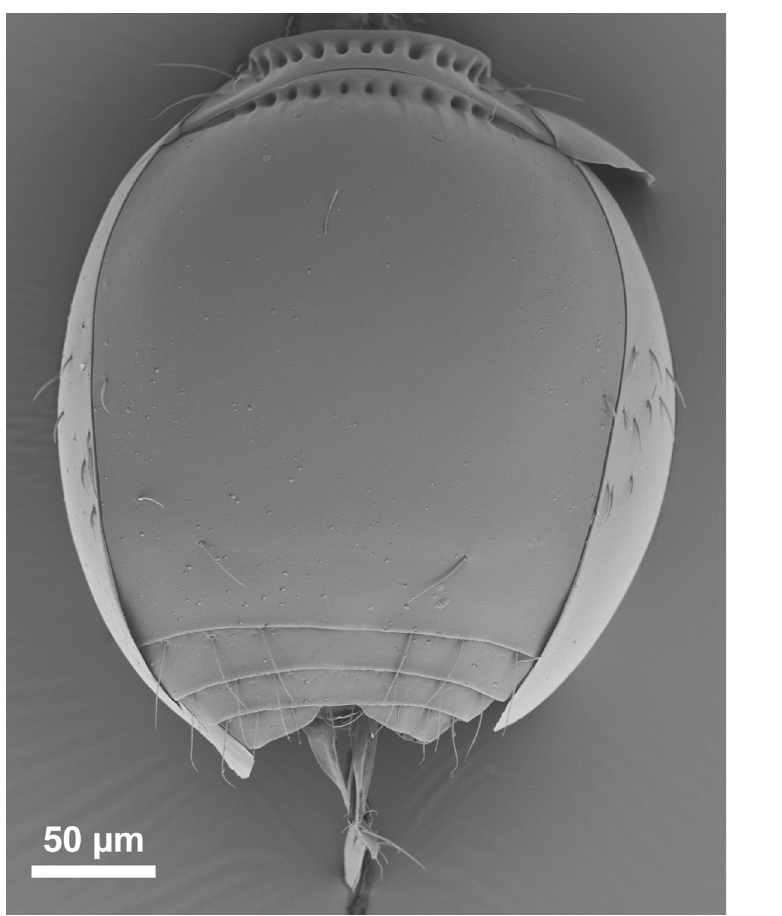
Fig 7. Telenomus nizwaensis Polaszek female paratype. Ventral